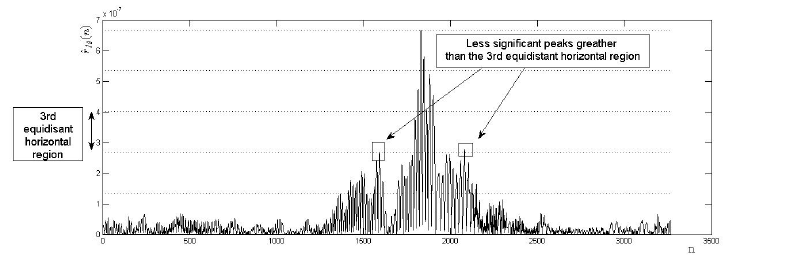
Figure 13. Example of possible errors due to sub-domain deformations: genuine matching incorrectly verified as rejected.